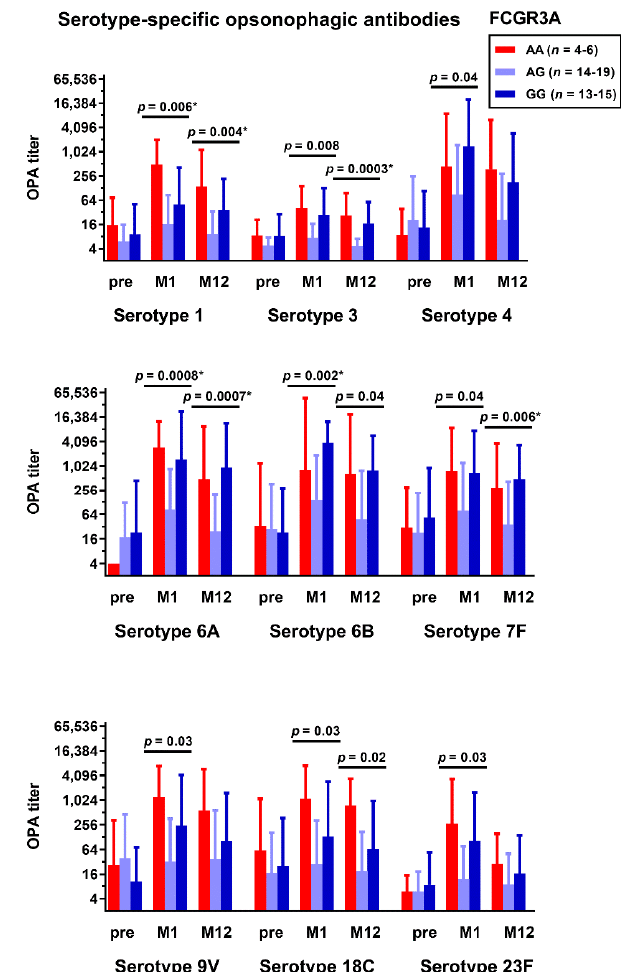
Figure 2. Kidney transplant recipients were genotyped for the FCGR3A rs396991 polymorphism and the serotype-specific opsonophagocytic antibody (OPA) responses, as determined prior to pneumococcal vaccination (pre) and at month 1 (M1) and month 12 (M12) thereafter. The recipients were grouped by genotype. OPA titers are shown on a logarithmic scale (log2) as geometric mean titers and geometric standard deviation factors [39] . The three groups were compared by Kruskal–Wallis test with Dunn’s multiple comparisons test. The results that remained significant after Bonferroni correction are marked with an asterisk.